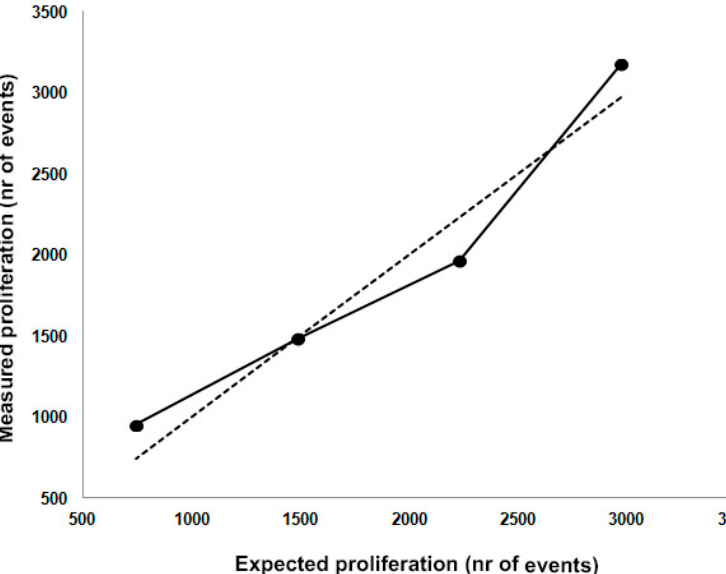
Figure 4. Definition of the experimental error. Continuous line represents the observed data in terms of the number of proliferated events. Dashed line represents the “true” values based on the calculated expected proliferation as reported in Table 1.